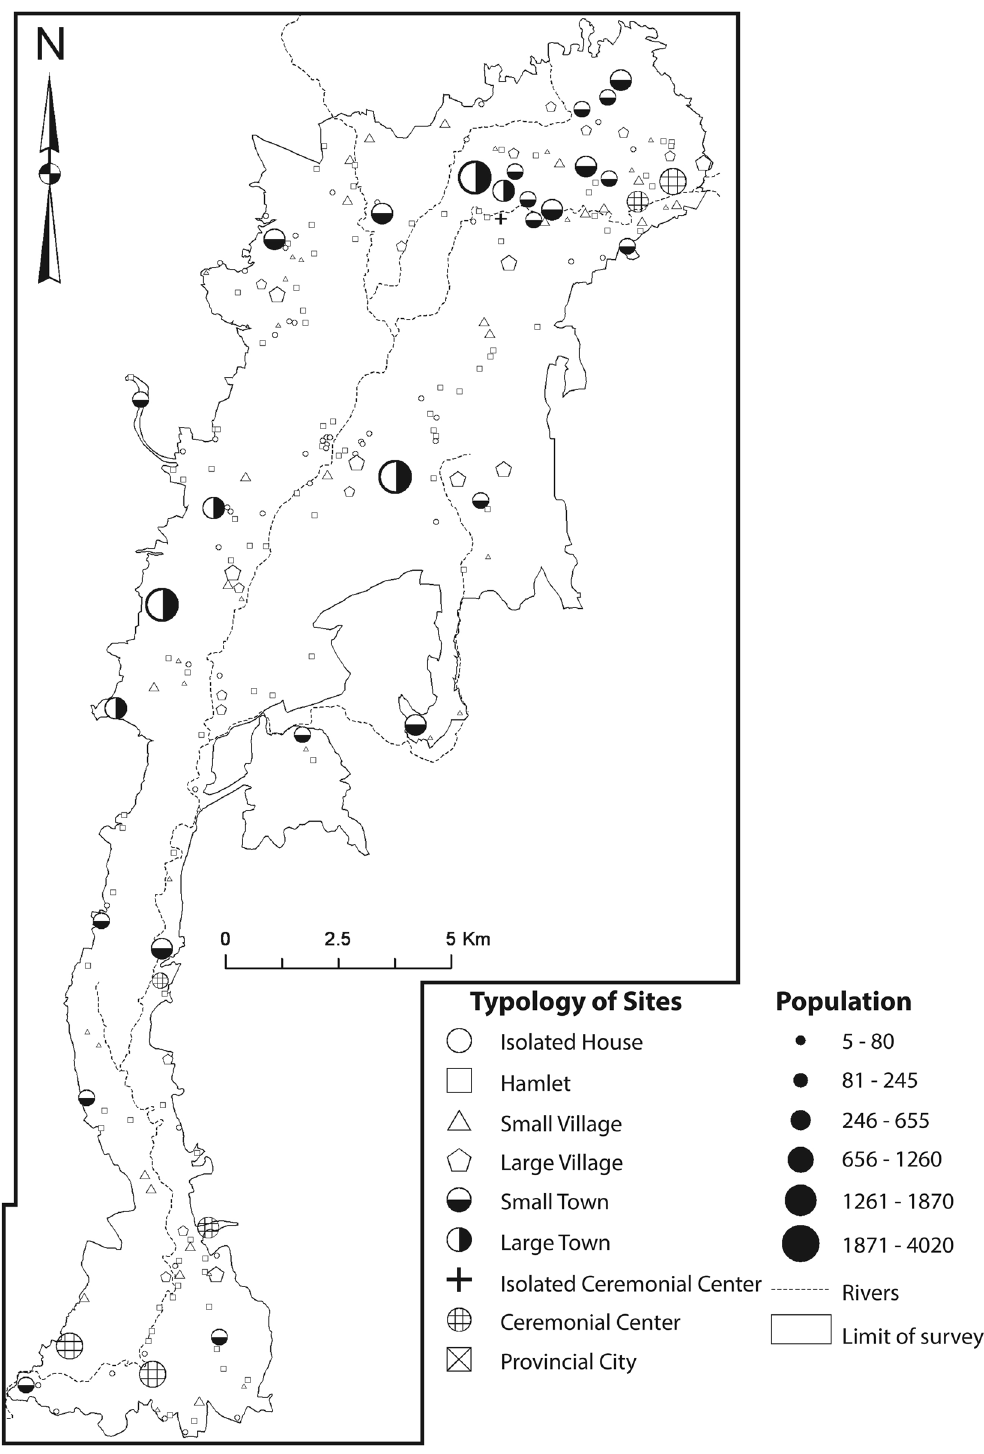
Figure 9: Settlement patterns of the Early Classic